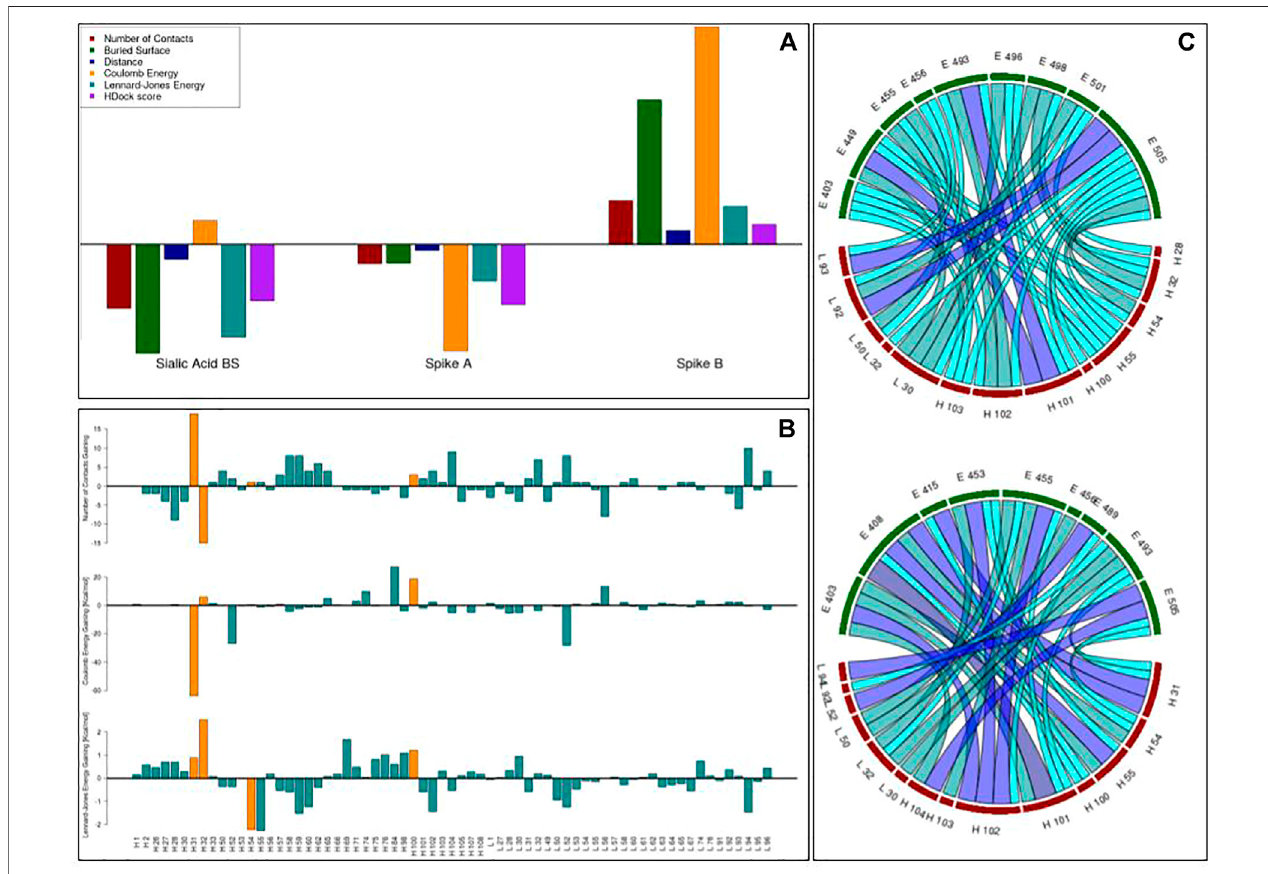
FIGURE 4 | Results of the docking analysis. (A) Each bar represents the relative gaining (in terms of the number of residue – residue inter-molecular contacts, the surface buried inthe complex, the mean inter-moleculardistanceof theclosest atoms,the inter-molecular Coulomb energy, the inter-molecularLennard – Jones energy, and theHDockbindingscore)betweenthe10bestdockingposesobtainedwiththeoriginalandtheoptimized antibodies.Apositivevaluemeansanincreaseinbinding compatibility. (B) Thegainingin terms of thenumber ofinter-molecular contacts, Coulomb energy, and Lennard – Jones energyeach residue registered before and aftertheoptimization. (C) Thenetworkofresidue – residueinteractionsattheinterfacewhentheoriginal(upper fi gure)ortheoptimized(lower fi gure)antibodyisdockedto the spike B region. The color, from cyan to dark blue, and the width of the edges re fl ect the occurrences in the docking poses of a given